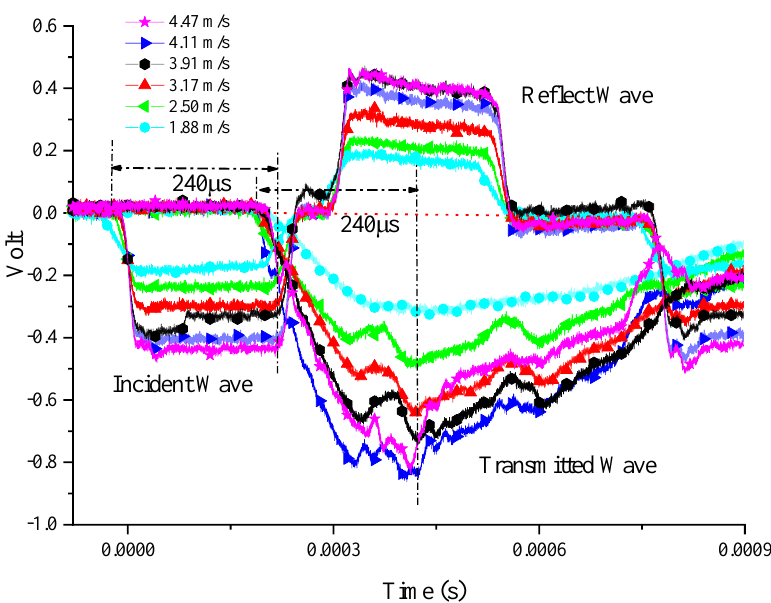
Figure 3. Experimental waveform of 15° SCSs at different impact speeds.